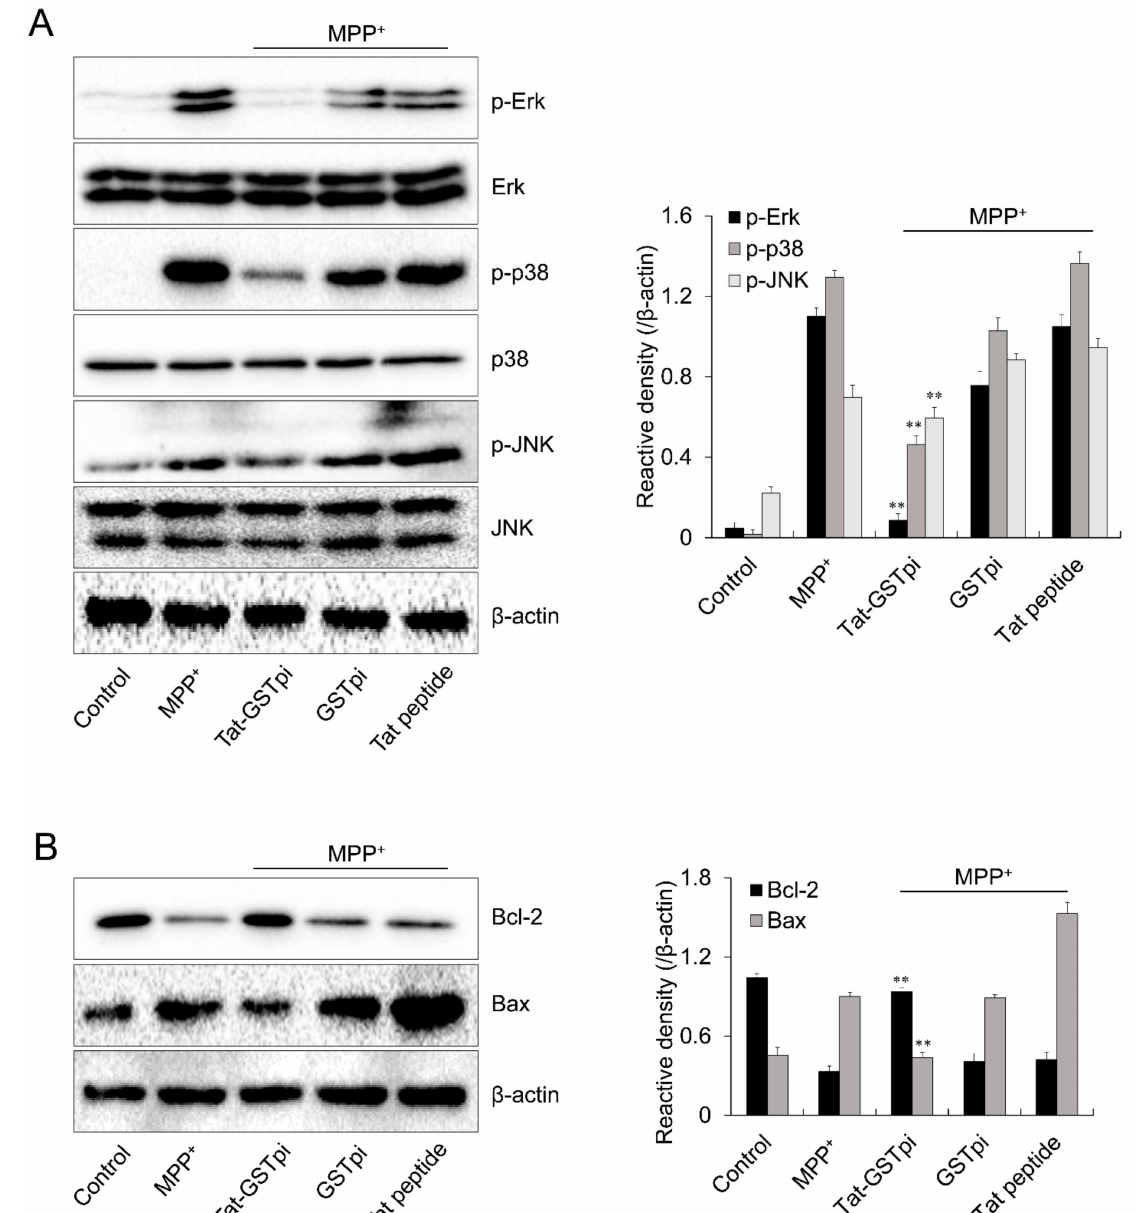
Figure 5. Effects of Tat-GSTpi protein on MPP + -induced expression of phosphorylation of MAPKs and apoptosis in SH-SY5Y cells. The cells were treated with Tat-GSTpi protein (3 µ M), GSTpi protein, and Tat peptide for 1 h before being exposed to MPP + (5 mM). The expression of phosphorylation of ( A ) MAPKs and ( B ) Bcl-2 and Bax levels were analyzed by Western blotting. Band intensity was measured by densitometer. Data are represented as mean ± SEM ( n = 3). ** p < 0.01, compared with MPP + -treated